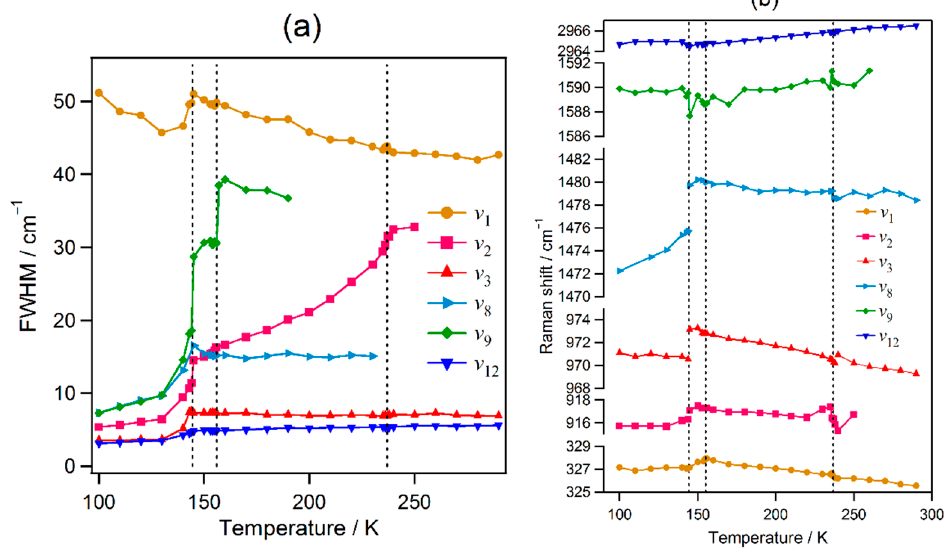
Figure 2. Temperature dependence of the ( a ) widths and ( b ) peak positions of the Raman bands of MAPbBr 3 . of MAPbBr 3